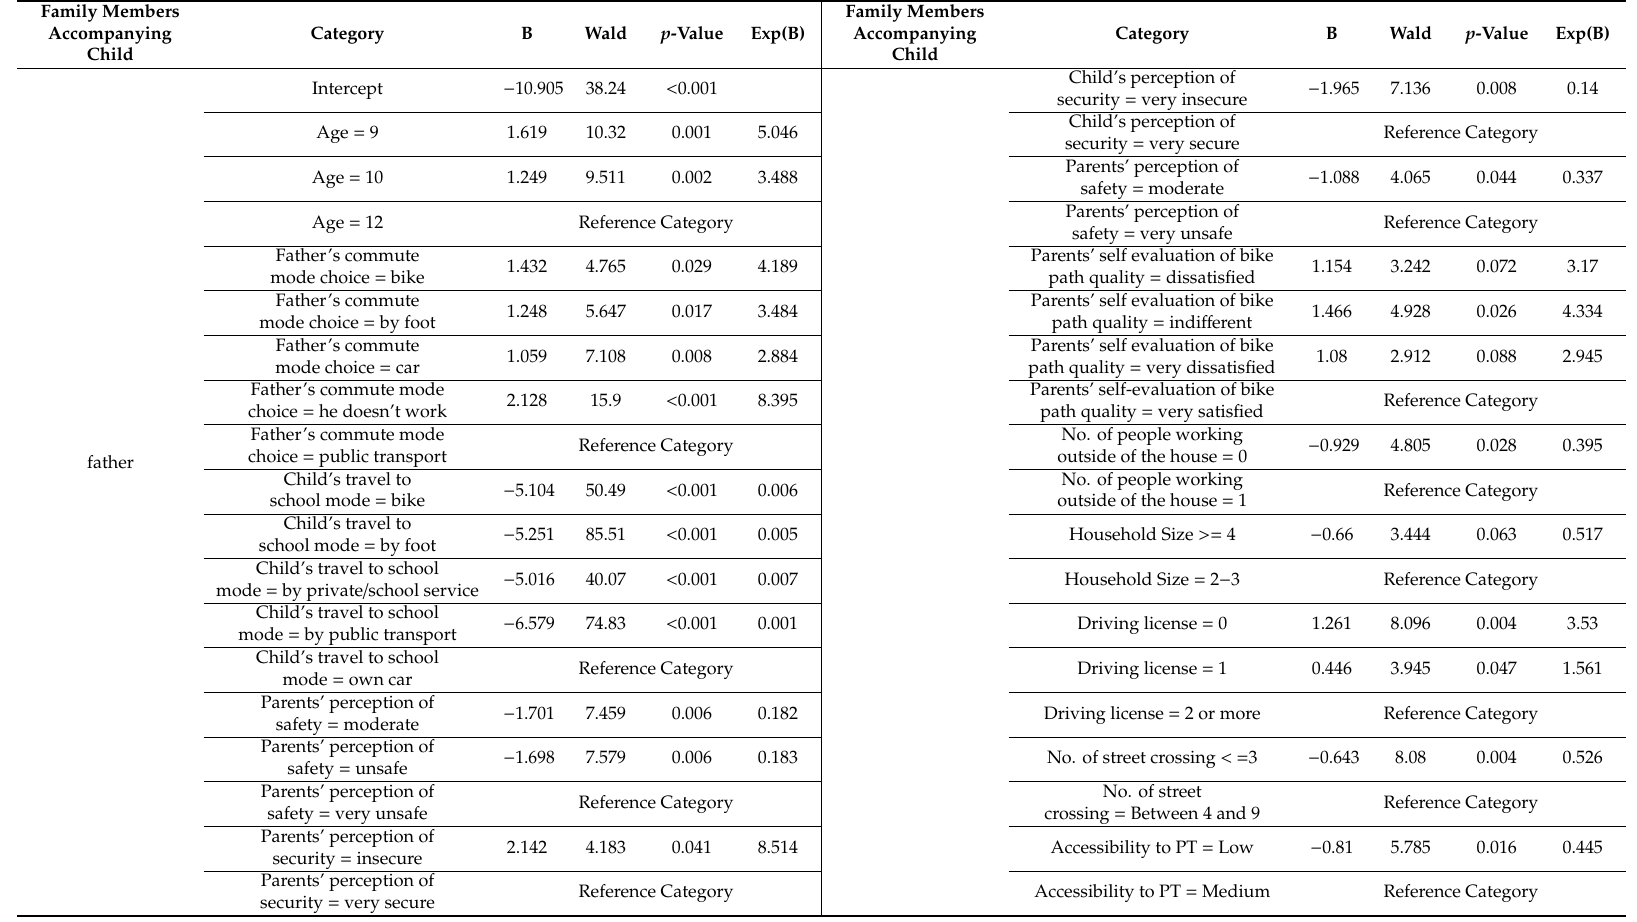
Table 5. MNL model explaining the coe ffi cients and significance of response categories with the reference-dependent category of independent mobility to school (no one accompanying) ( n =